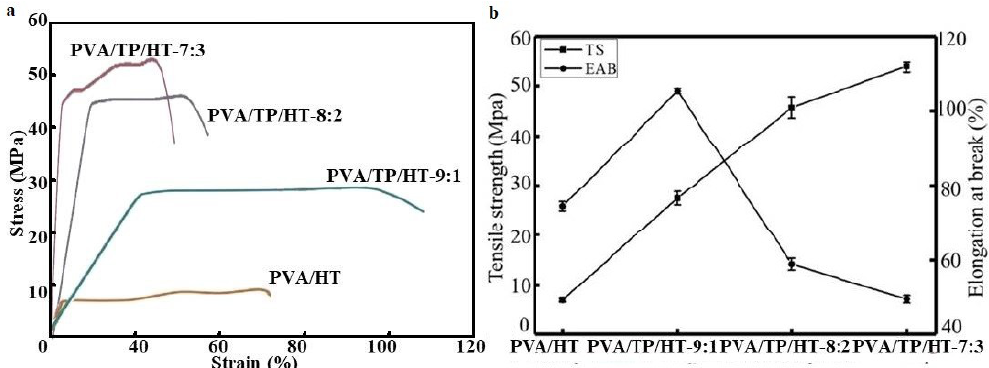
Figure 5. ( a ) Stress–strain curves; ( b ) trend diagram of tensile strength (TS) and elongation at break (EAB) of PVA/HT, PVA/TP/HT-7:3, PVA/TP/HT-8:2, and PVA/TP/HT-9:1 nanofiber films. (EAB) of PVA / HT, PVA / TP / HT-7:3, PVA / TP / HT-8:2, and PVA / TP / HT-9:1 nanofiber